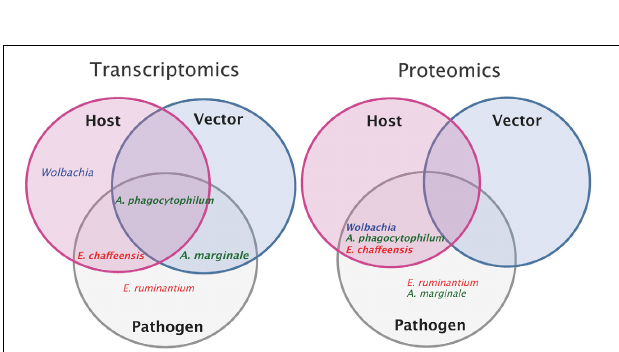
FIGURE 2 | Overview of pathogen, host, and vector transcriptomic and proteomic studies. Transcriptomic or proteomic studies done on host (pink circle) and on vector (blue circle) after pathogen infection (the name of the pathogen is indicated for each study). Transcriptomic or proteomic studies done on the pathogen (gray). Intersections of circles correspond to studies done both on the pathogen and on host or/and vector. In example, transcriptomic studies of Anaplasma phagocytophilum and of its host and vector have been done whereas only proteomic studies of Anaplasma phagocytophilum and its host have been